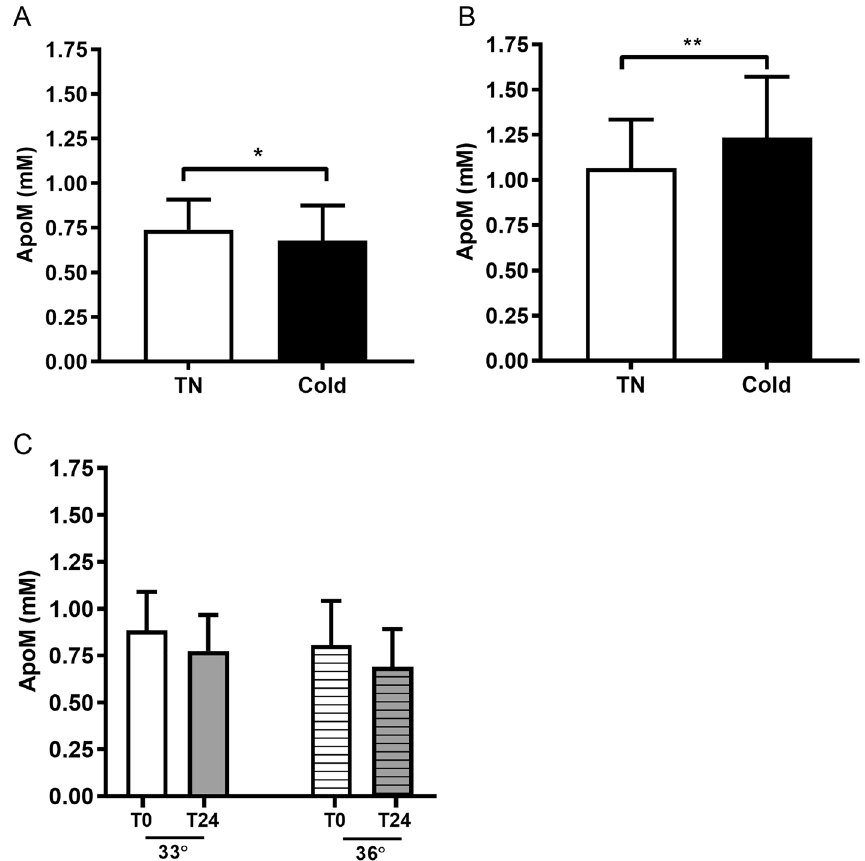
Figure 3. ApoM plasma levels in STC-CPH (A), STC-LEI (B), and LTC (C). Thermoneutral (TN) and cold refers to pre-cooling and after cold exposure (2 h) in STC-CPH (n = 15) and STC-LEI (n = 20). In LTC samples were taken at 0 and after 24 h at either 33˚C (n = 20, intensified cold) or 36˚C (n = 24, cold maintenance). Data are presented as mean with error bars as SD. In A and B, data are analyzed with a paired t-test or Wilcoxon signed-rank test depending on normal distribution. In C, data are analyzed with a two-way mixed ANOVA with time and temperature as variables. * P < 0.05, ** P < 0.01, *** P < 0.0005 for TN vs Cold. STC-CPH; short-term cold, Copenhagen. STC-LEI; short-term cold, Leiderdorp. LTC; long-term